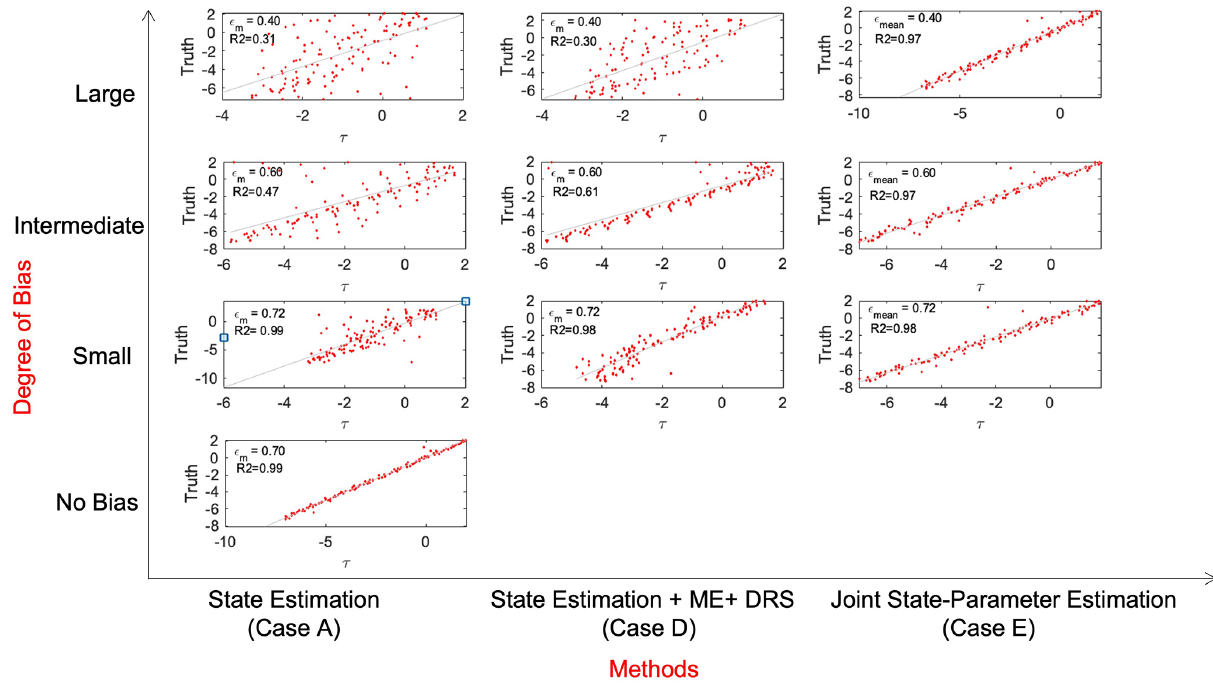
Figure 11. Comparison of regression between the estimate of τ and the true τ , showing the corresponding R 2 values for the three bias cases (rows) and for different assimilation approaches (columns). The red dots indicate the estimated values or the posterior and true τ values at the observation times. A diagonal line is added for